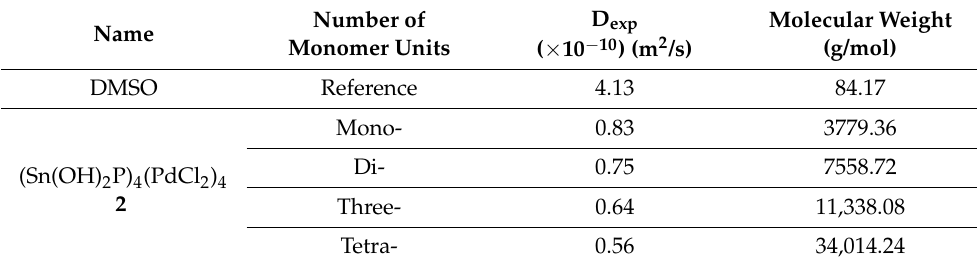
Table 2. Summary results of DOSY NMR experiments, for the object of study 2 with the values of the molecular masses of the complexes, and the diffusion coefficients determined from the experiments. The molecular weight and diffusion coefficient of dimethyl sulfoxide-d6 (DMSO-d6) are used as a reference in the calculations.